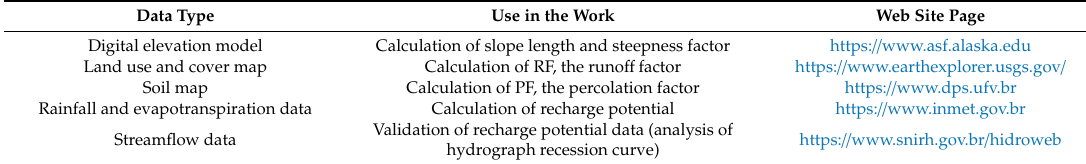
Table 6. Material used in the groundwater recharge